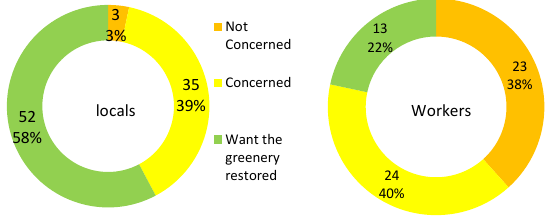
Figure 9: No. od people concerned about deforestation w.r.t. local vs workers.